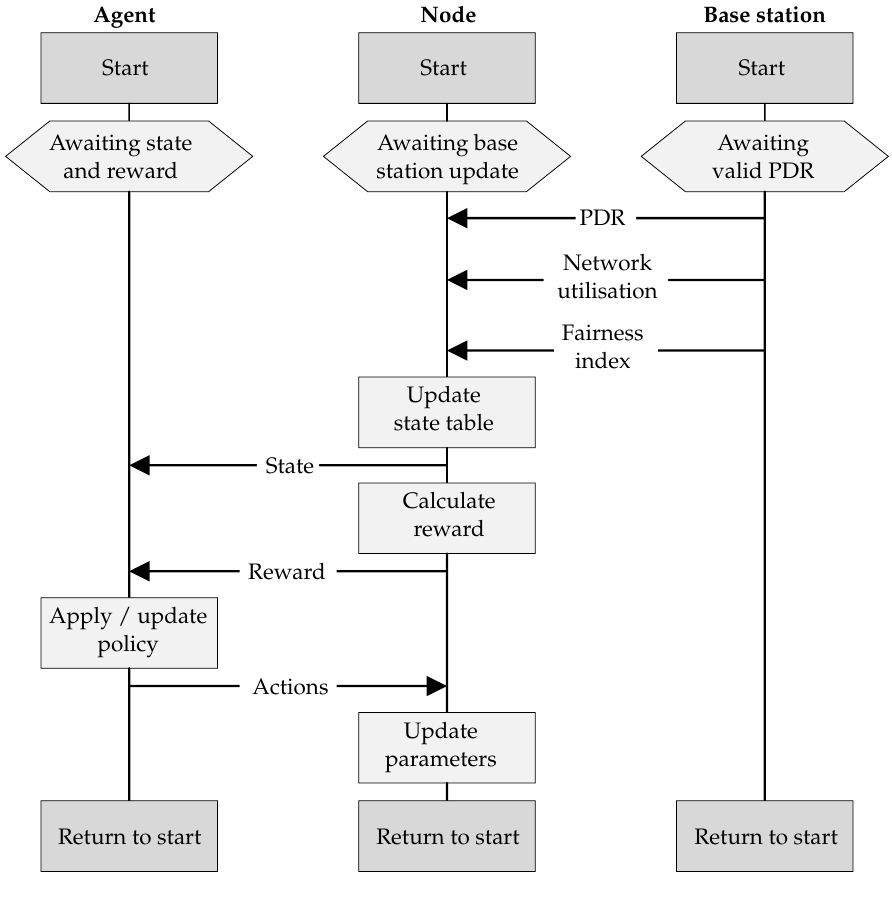
Figure 5. Message sequencing among the agent, node, and base